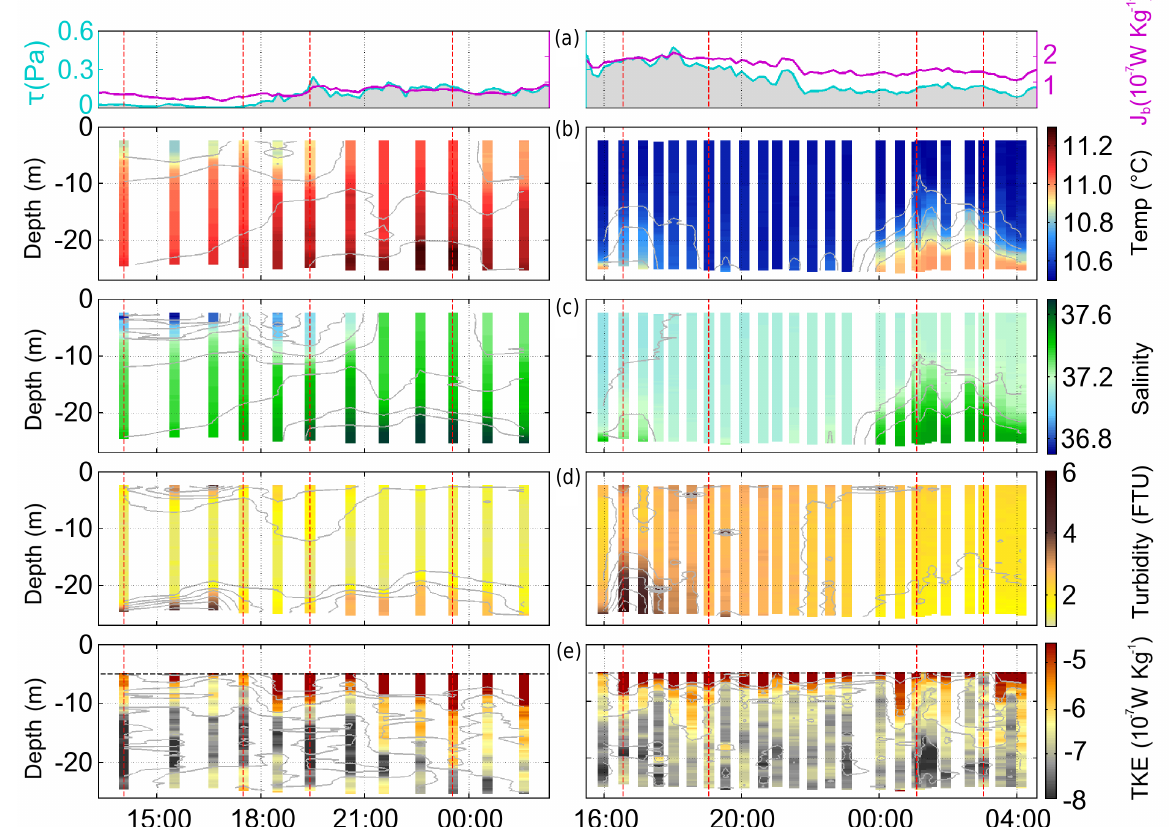
Figure 9. Hovmöller diagrams of Y02 (left) and Y03 (right). Panels shows (a) wind stress (cyan) and buoyancy flux (magenta), (b) tem- perature profiles (grey contours are spaced 0.1 ◦ C), (c) salinity profiles (grey contours are spaced 0.1), (d) turbidity profiles in FTU (grey contours are spaced 1FTU) and (e) turbulent kinetic energy dissipation rate in logarithmic scale (contours spaced in log of 1Wm − 2 ) . Red dashed lines show the time of collection of the yoyo casts reported in Fig.